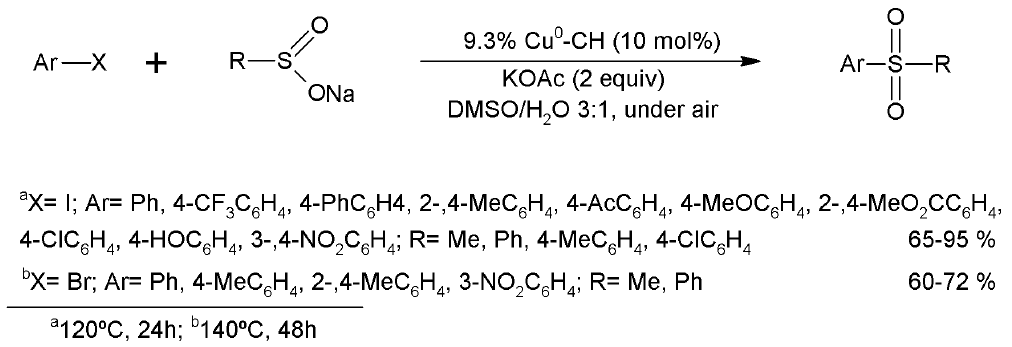
Figure 23. Coupling of haloarenes and sodium sulfonates using chitosan-based catalysts loaded with Cu 0 .